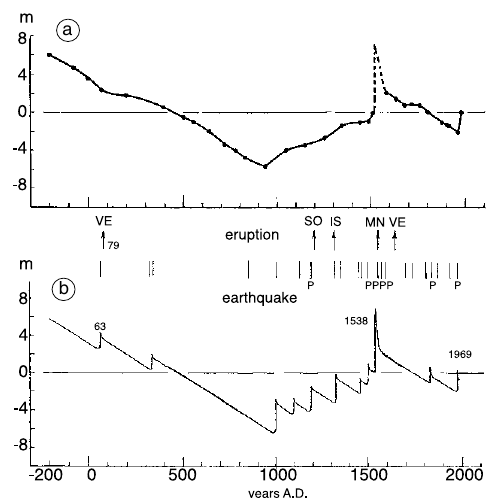
Fig. 2a,b. Deformation trends of Serapeo proposed by (a) Parascandola (1947) and (b) Casertano et al . (1976). Eruptions: arrows indicate major local eruptions probably capable to effect Pozzuoli (VE: Vesuvius; SO: Solfatara; IS: Ischia; MN: Monte Nuovo). Earthquakes: bars indicate major earthquakes in Campania, and bars with letter P do earthquakes in the Pozzuoli